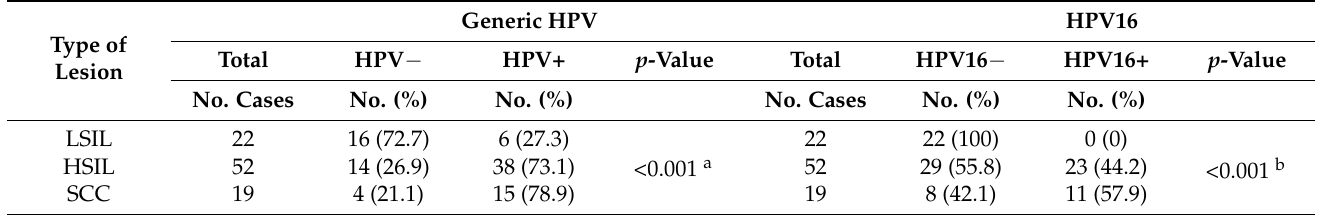
Table 2. Frequency of generic HPV and HPV16 according to the type of cervical